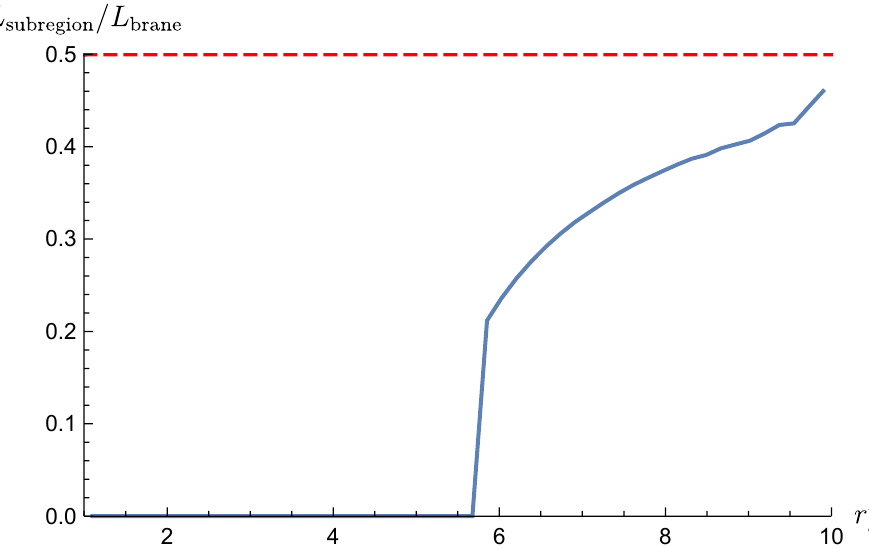
Figure 16 . The growth of the brane fraction L subregion =L brane captured by the minimal infalling geodesic plus brane entropy combination (with the same parameters as (cid:12)gure 15). Notice that, comparing with (cid:12)gure 15, the partial island is already more than 30% of the brane by the time the infalling geodesic becomes more minimal than the inception causal horizon (around r 0 The red dashed line at fraction 1 is the maximum possible value of the blue curve for our choice 2 of equal inception moduli, and the protocol ends at about 45% brane fraction. So, at the end of the protocol ( r 0 (cid:25) 10), the union of the entanglement wedges of R 1 and R 2 capture about 90% of h the total brane length. But, the entanglement wedge of R 1 [ R 2 captures 100% of the total brane length immediately after the Page